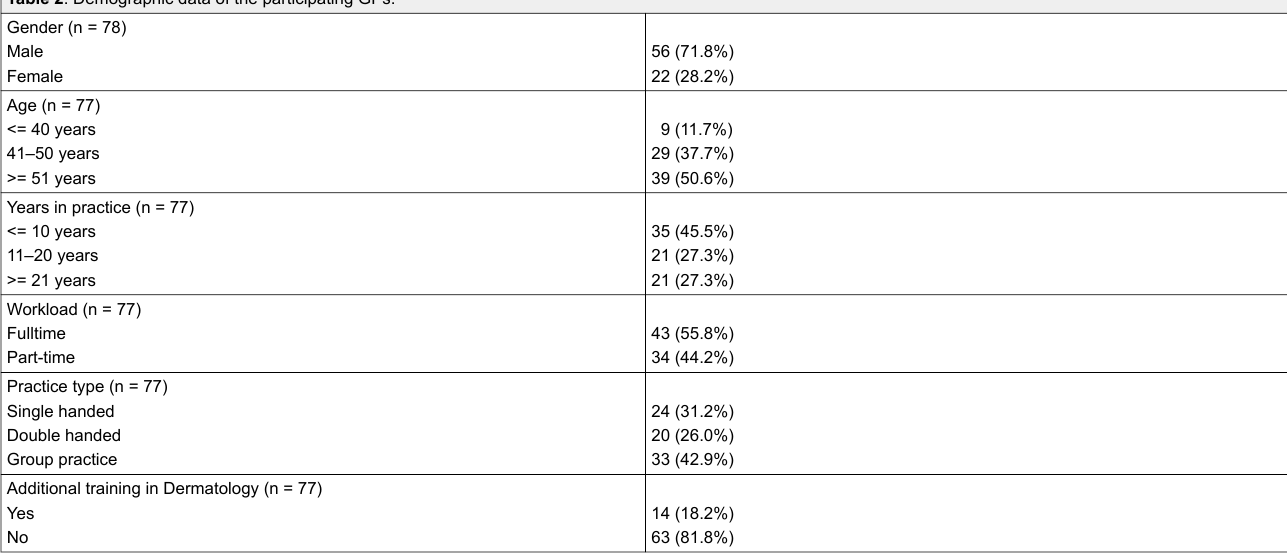
Table 2 : Demographic data of the participating GPs. Gender (n = 78)